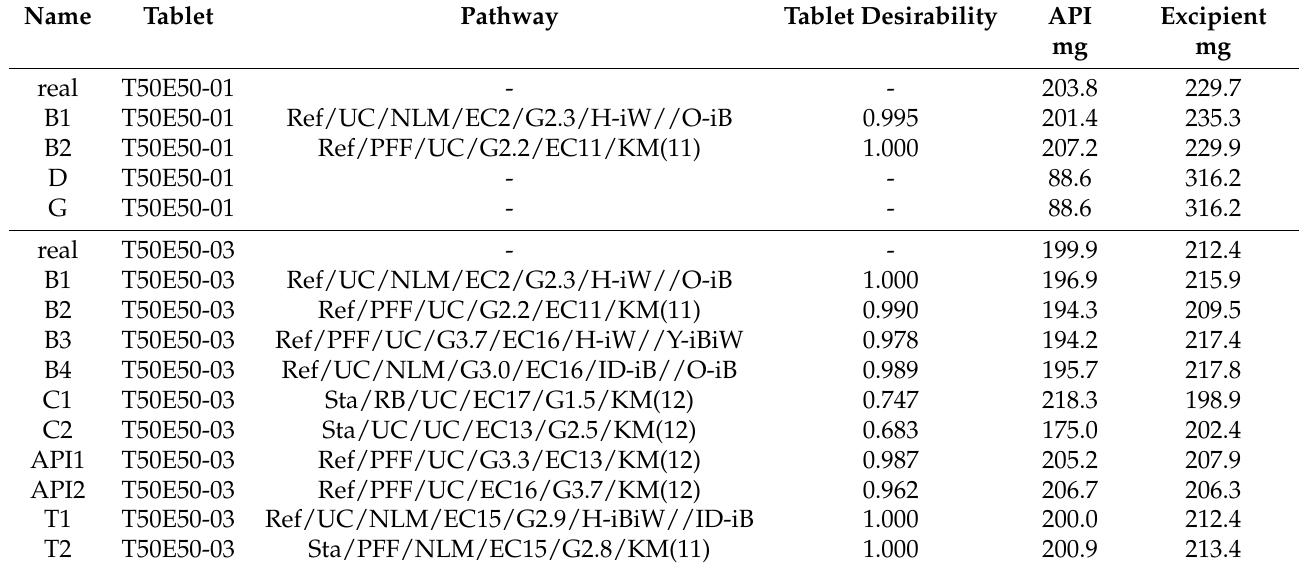
Table A1. The selected images for the in silico calculations. The line called real displays the determined real data of the